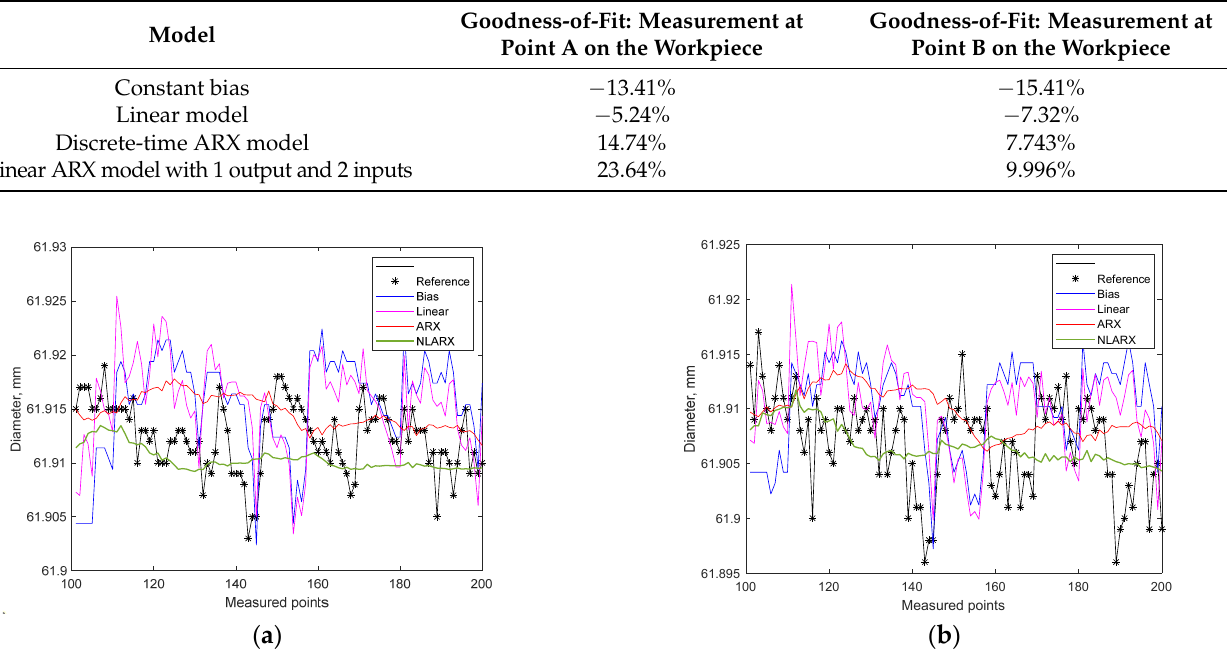
Figure 13. Comparison of estimation results for a part of the data (100 measured workpieces): ( a ) measurement at point A on the workpiece; ( b ) measurement at point B on the workpiece.